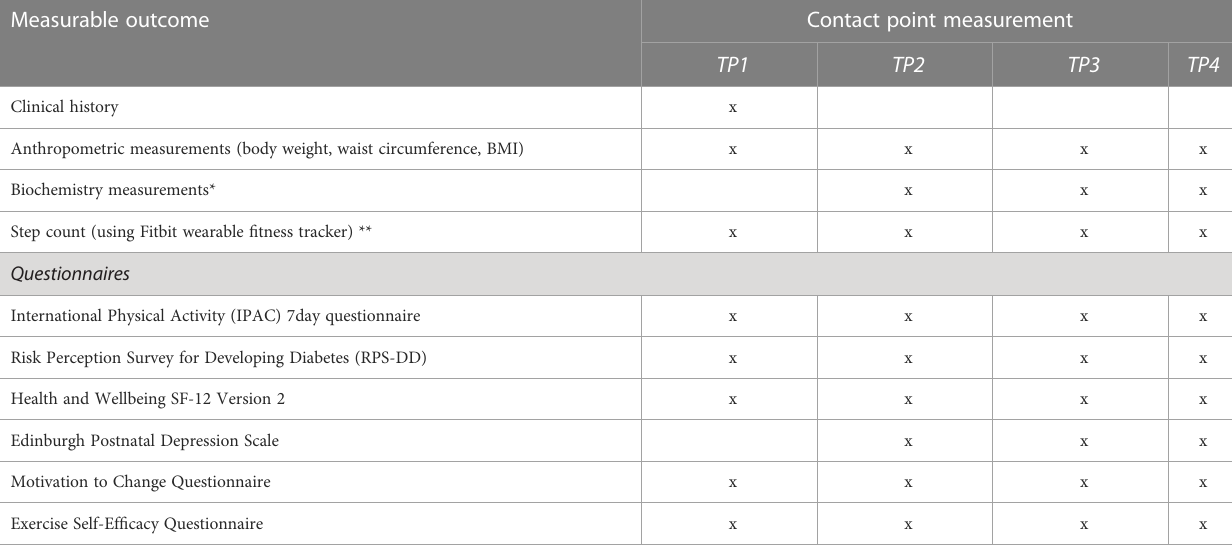
TABLE 1 Measurable outcomes and their collection timepoints